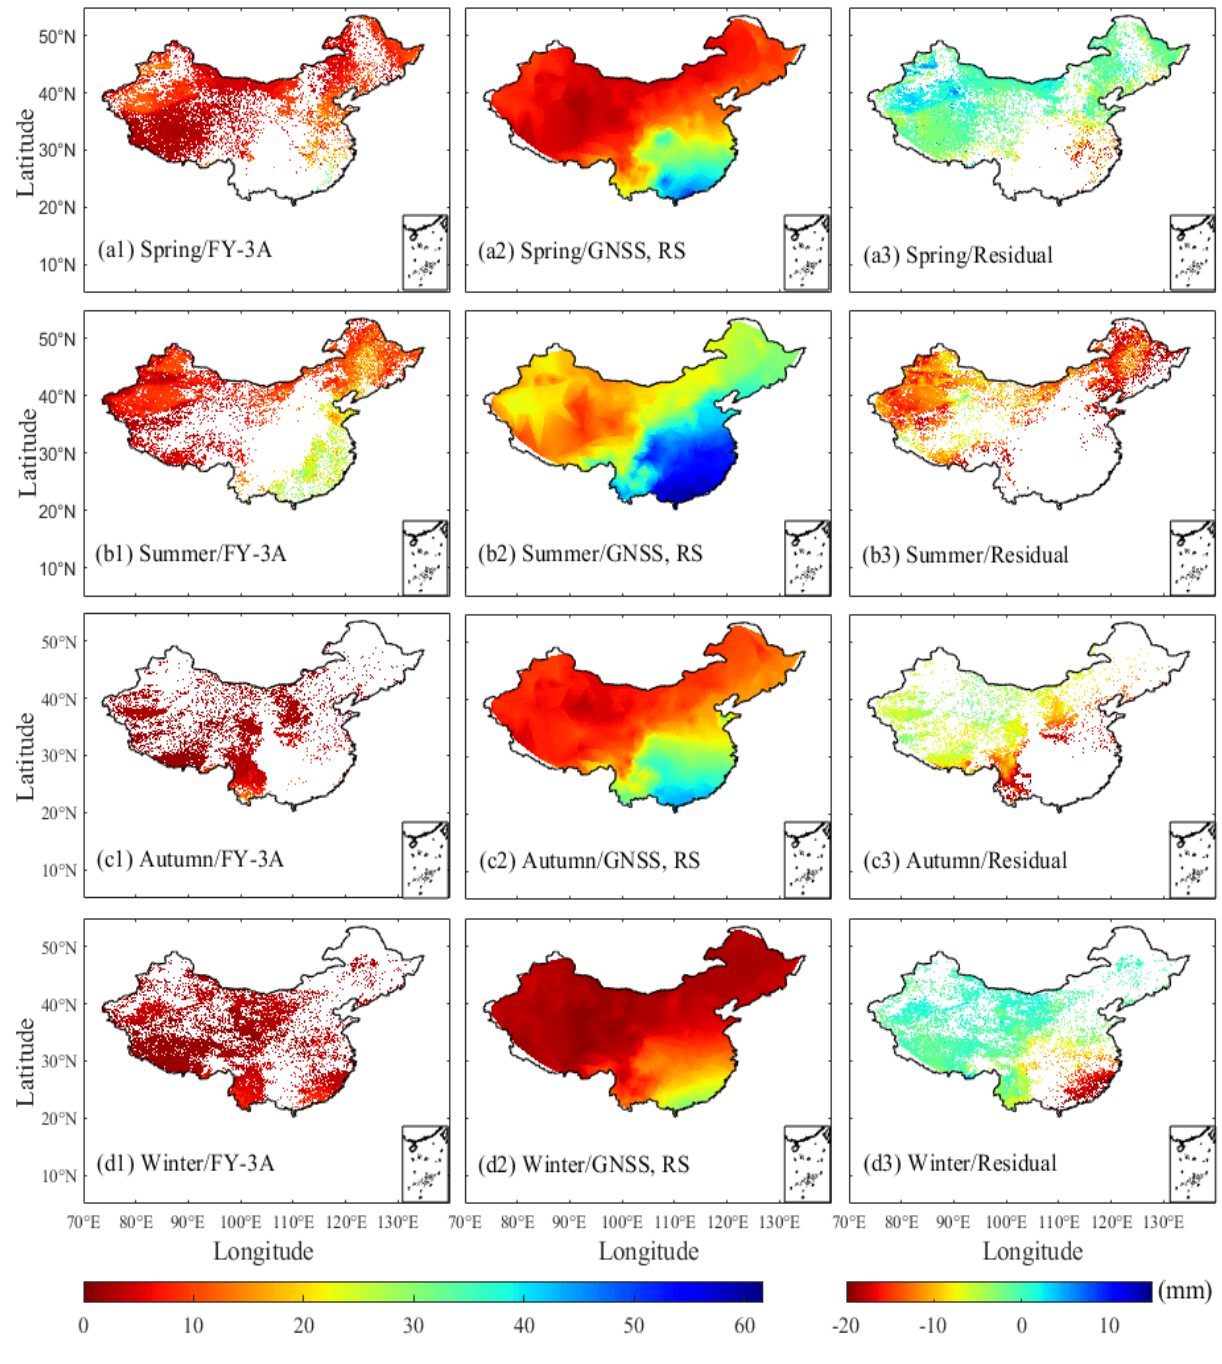
Figure 8. Two-dimensional image of PWV distributions at four seasons, where the first column is obtained from FY-3A, the second column is from the GNSS/RS and the last column is the PWV difference between the FY-3A and GNSS/RS over the period of 2012 to 2013.